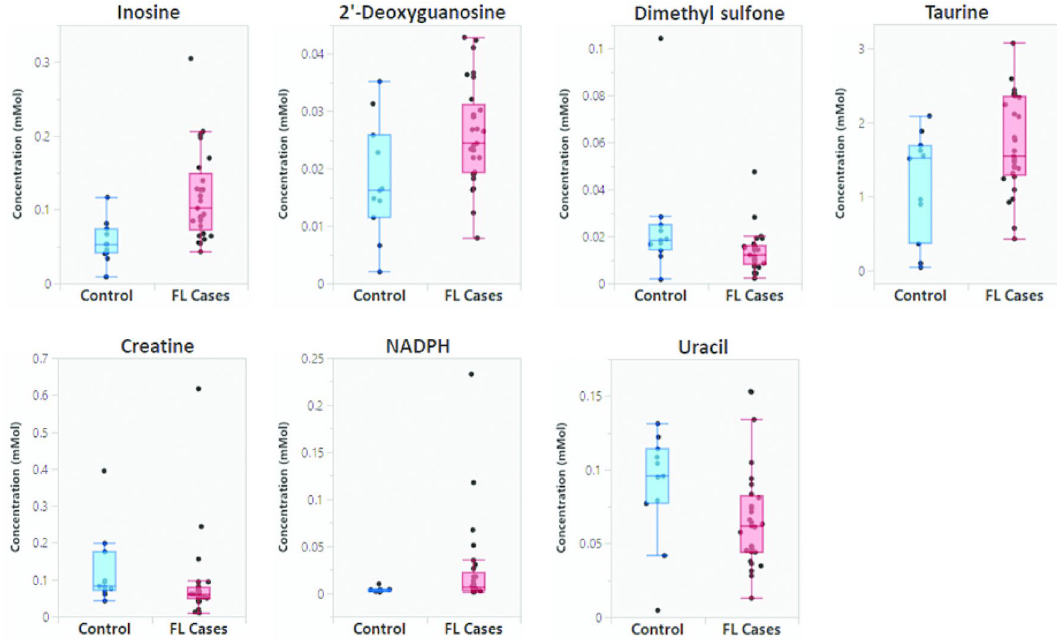
Figure 2. Dot and whisker plot showing the 7 metabolites highlighted by unpaired t-test analysis as being significantly different in follicular lymphoma cases relative to controls.